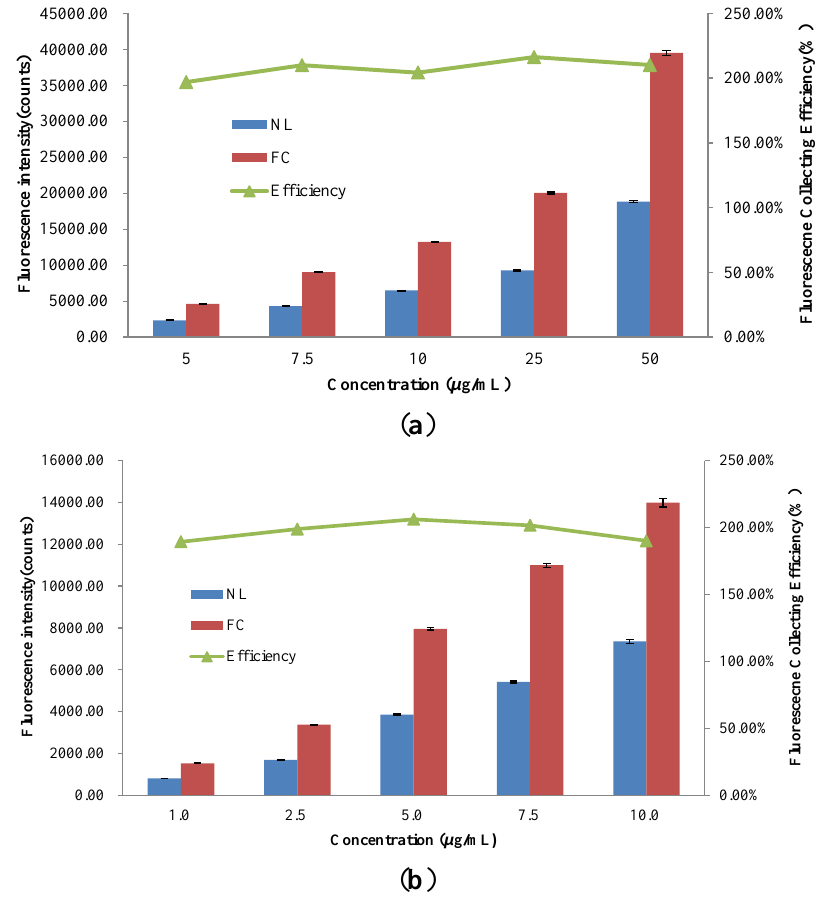
Figure 6. The fluorescence intensity obtained with fluorescence collecting lens (FC) and without lens (NL). The efficiency for fluorescence collection is also plotted for different concentrations of ( a ) Nile red and ( b ) Rhodamine 6G. The excitation laser has an incident angle of